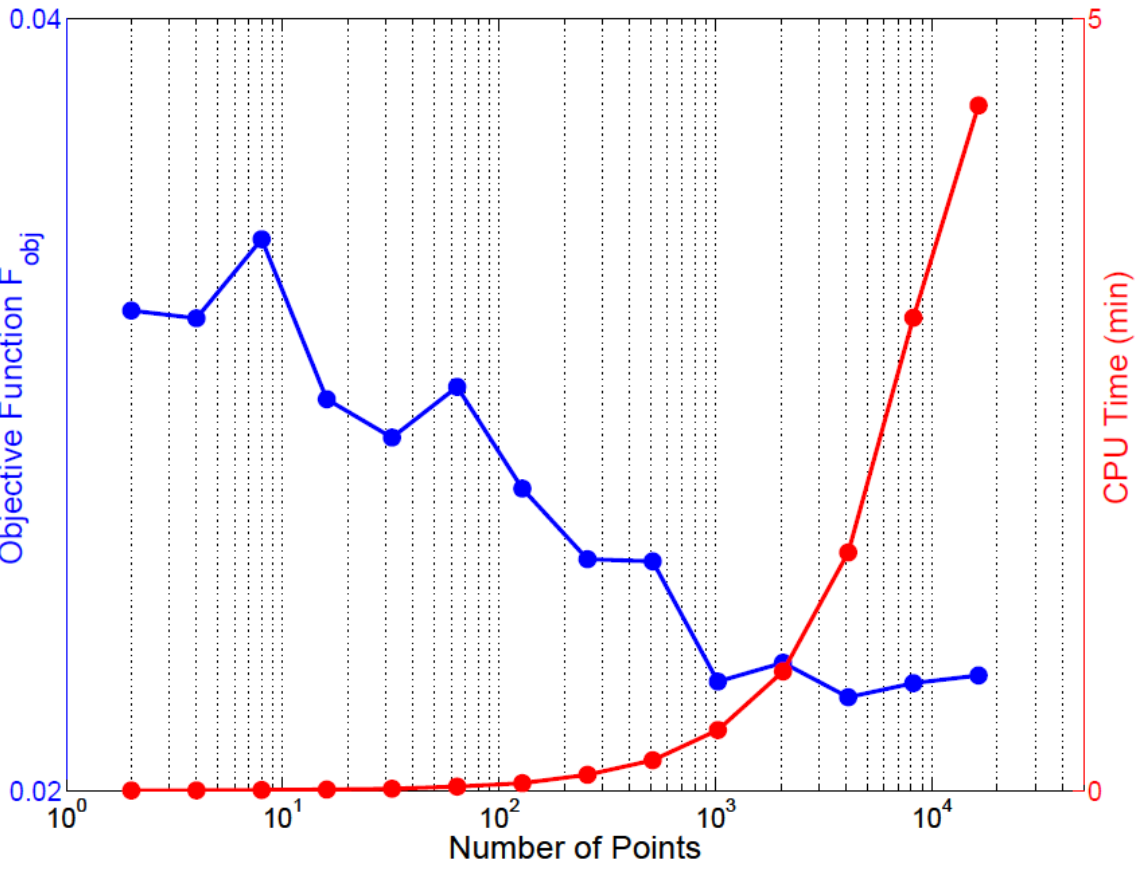
Figure 6. The objective function and computational CPU time as a function of the number of points in the Brute Force MC